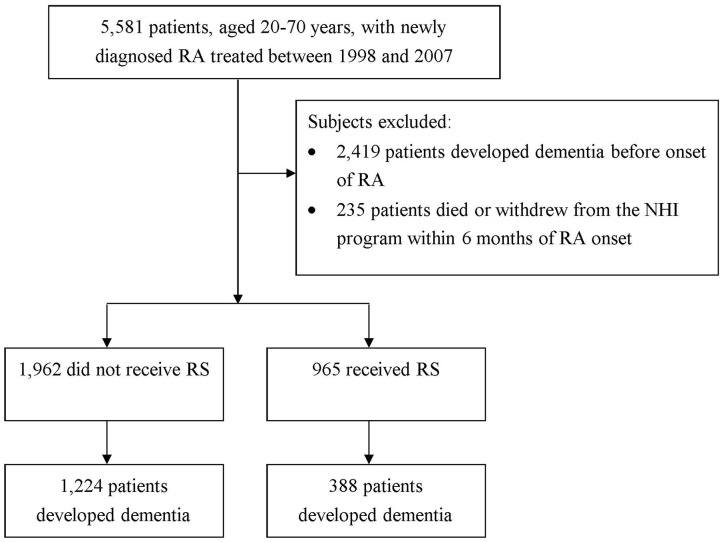
Disposition of study subjects.